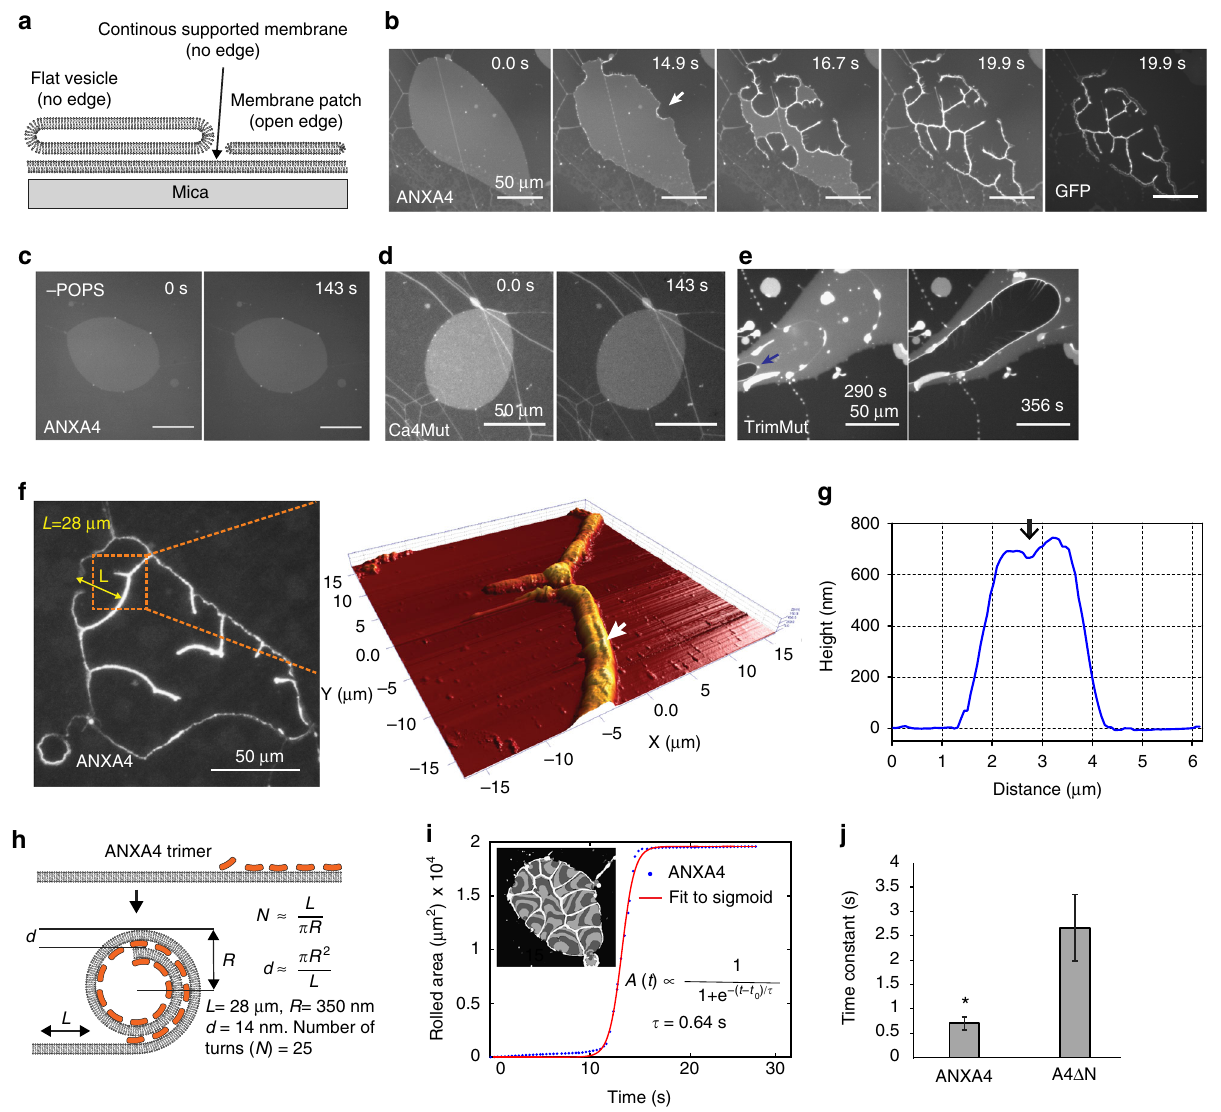
Fig. 3 ANXA4 induces membrane curvature in supported membranes. a Schematic of supported membrane model composed of primary and secondary membranes. Non-vesicular membrane patches with open edges were used in the subsequent experiments (POPC/POPS, 9:1 molar ratio). b Sequential images before and after addition of ANXA4-GFP protein to a membrane patch stained with DiD in the presence of Ca 2+ (last image GFP channel) (also, see Supplementary Movie 2). c Similar experiment as in b but without POPS in the supported membrane. d , e Mutants of ANXA4 proteins including d Ca4Mut or e TrimMut. Note: TrimMut exhibits > 10 times slower rolling activity. f Fluorescence and matching AFM image of membrane patch after completed rolling induced by ANXA4 and g AFM-topography graph of two colliding membrane rolls. h Schematic of ANXA4-induced membrane rolling including a numeric estimate of the number of turns N and layer spacing d . i Calculation of time constant ( τ ) for membrane rolling and corresponding data for ANXA4. ANXA4-GFP shows similar rolling activity (data not shown). j Rolling time constants for ANXA4 and A4 Δ N, respectively. Error bars represent S.D. for three – fi ve independent experiments. P values based on t -test: * P ≤ 0.05, *** P ≤